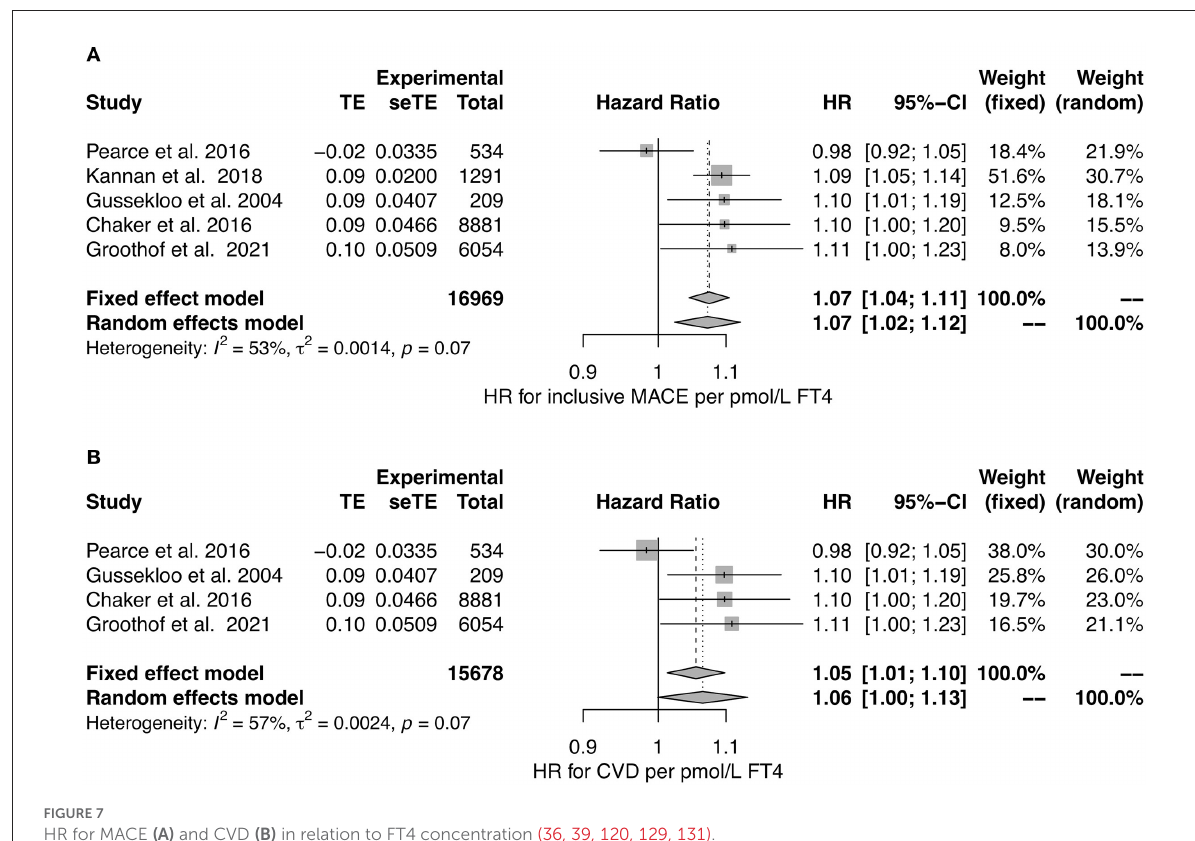
fundamentally opposing effects on generator loops, probably mediated via IP3